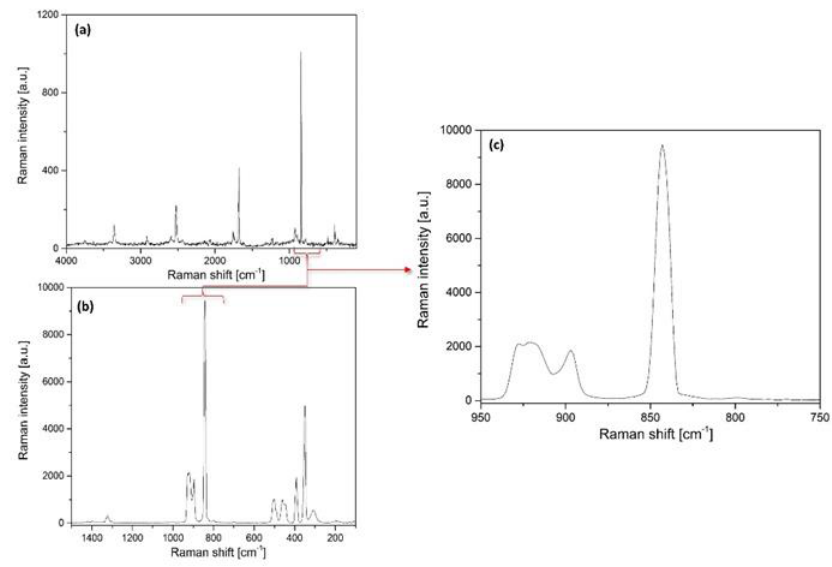
Figure 7. Raman spectra of compound 1 with ( a ) 532 and ( b , c ) 785 nm